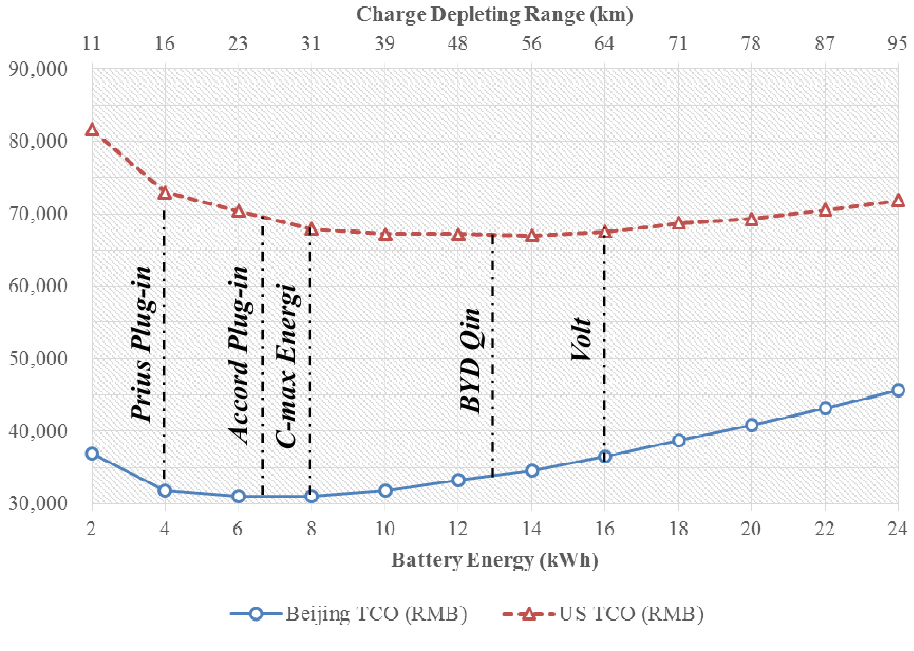
Figure 9. TCO curve comparison between Beijing and U.S. range